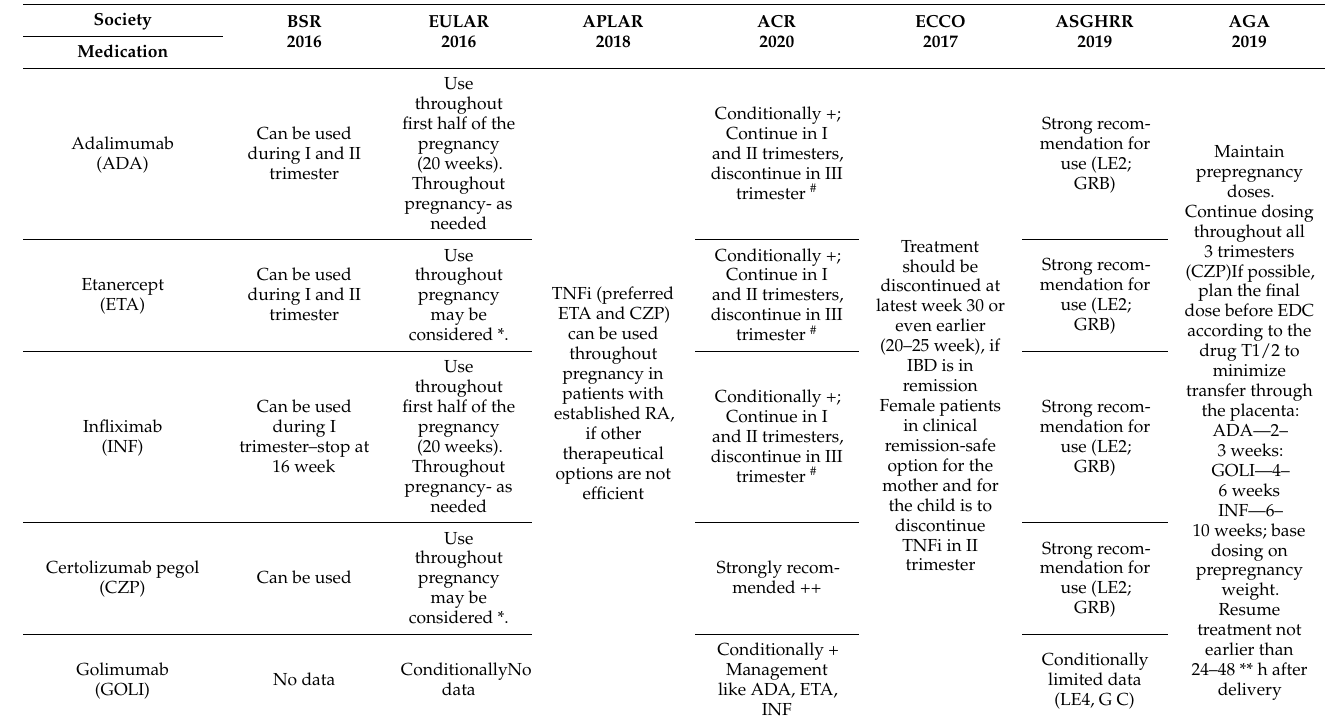
Table 3. TNF-alpha inhibitors management in patients with inflammatory diseases during pregnancy based on the recommendations/guidelines of: (i) Rheumatological Medical Societies: British (BSR—The British Society for Rheuma- tology and BHPR (British Health Professionals in Rheumatology) [78]; European (EULAR—European League Against Rheumatism) [130]; Asia Pacific Region (APLAR—Asia Pacific League of Associations for Rheumatology) [131]; American (ACR—American College of Rheumatology) [77]; (ii) Gastroenterological Medical Societies: Austrian (ASGHRR- Austrian Societies of Gastroenterology and Hepatology and Rheumatology and Rehabilitation) [133], European (ECCO—European Crohn’s and Colitis Organisation) [132], American (AGA—American Gastroenterological Association) [134]. Medical Societies Recommendations for the Management of Inflammatory Diseases DURING PREGNANCY